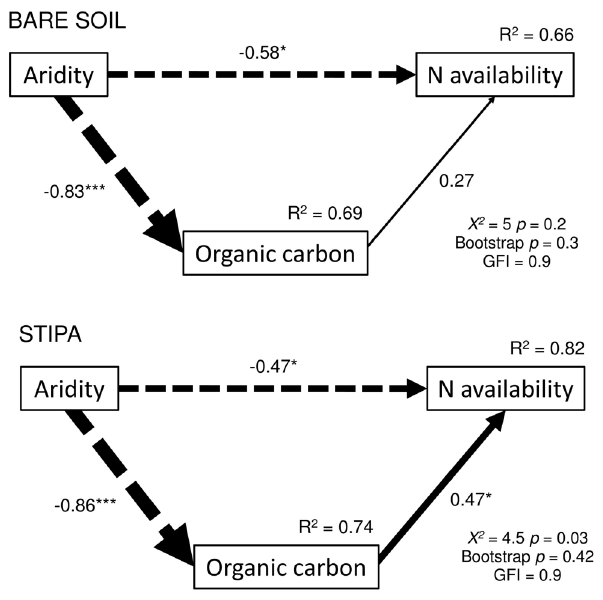
Figure 3. Structural equation models showing the direct and indirect effects of aridity and organic carbon on the total nitrogen availability for the Stipatenacissima (STIPA) and bare ground (BARE SOIL) microsites. Continuous and dashed arrows indicate positive and negative relationships, respectively. Width of arrows is proportional to the strength of path coefficients. The proportion of variance explained (R 2 ) appears above every response variable in the model. Goodness-of-fit statistics for each model are shown in the lower right corner. Significance levels are as follows: *p , 0.05, **p , 0.01 and ***p ,